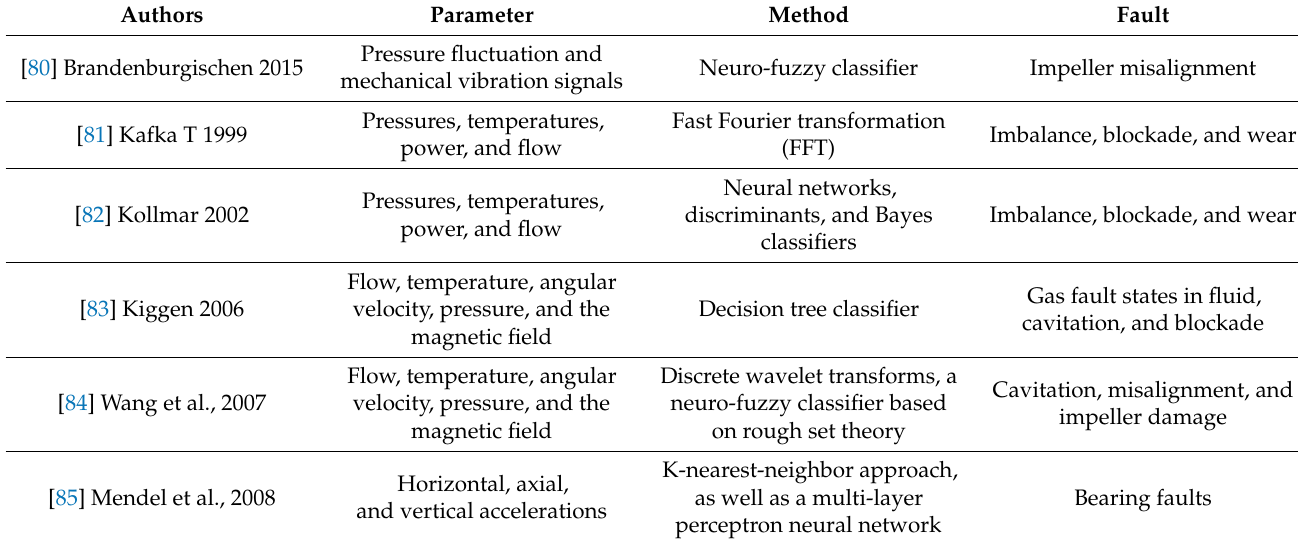
Table 2. Signal model-based